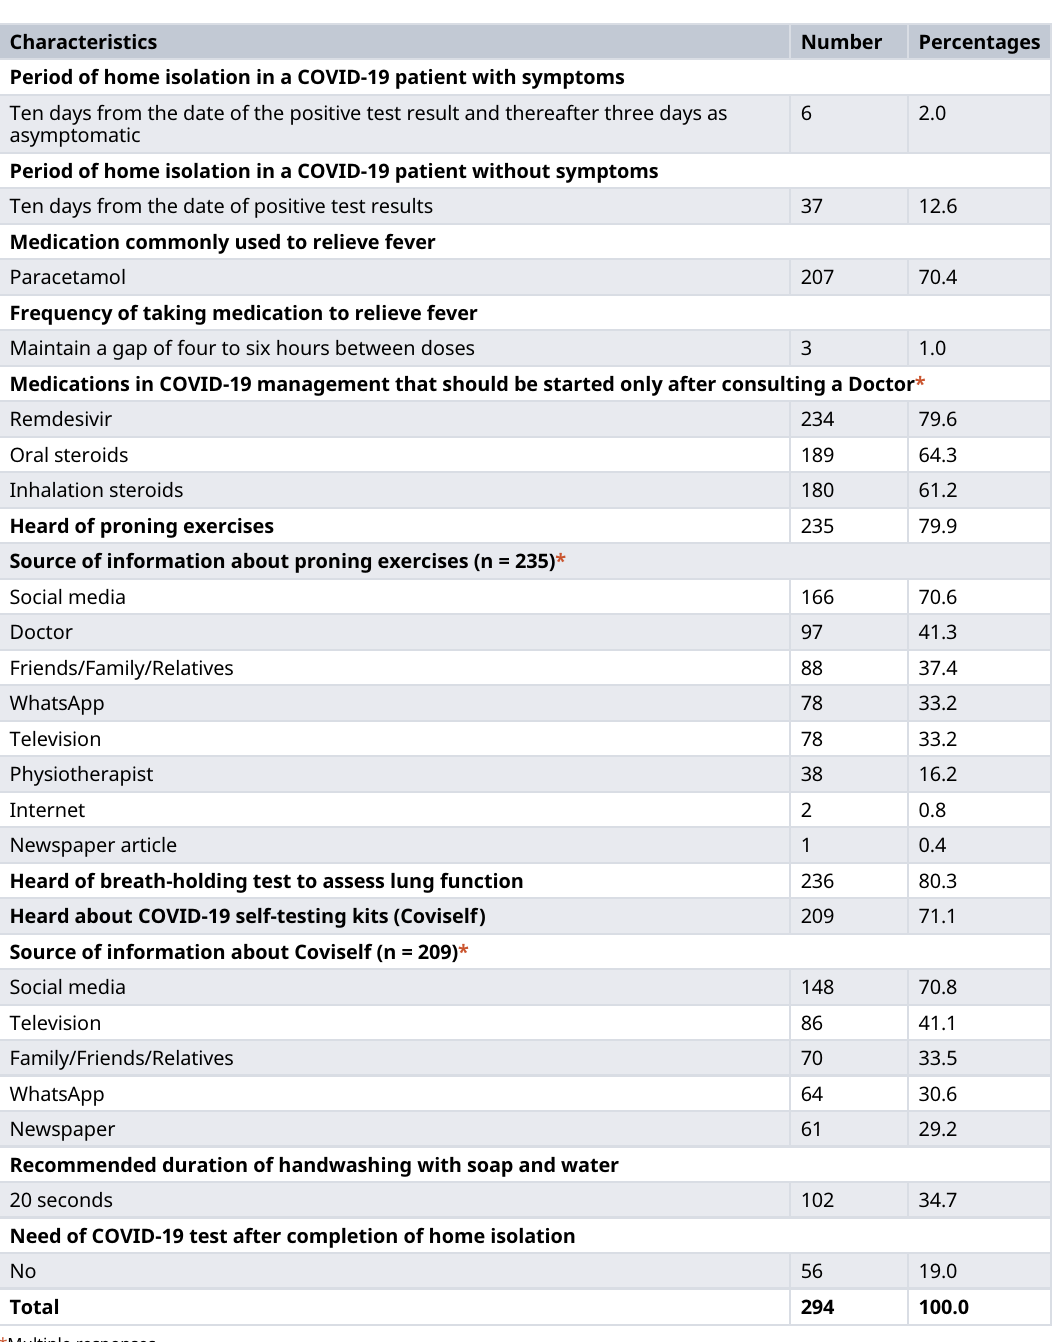
Table 5. Awareness of COVID-19 management practices among the participants. Characteristics Number